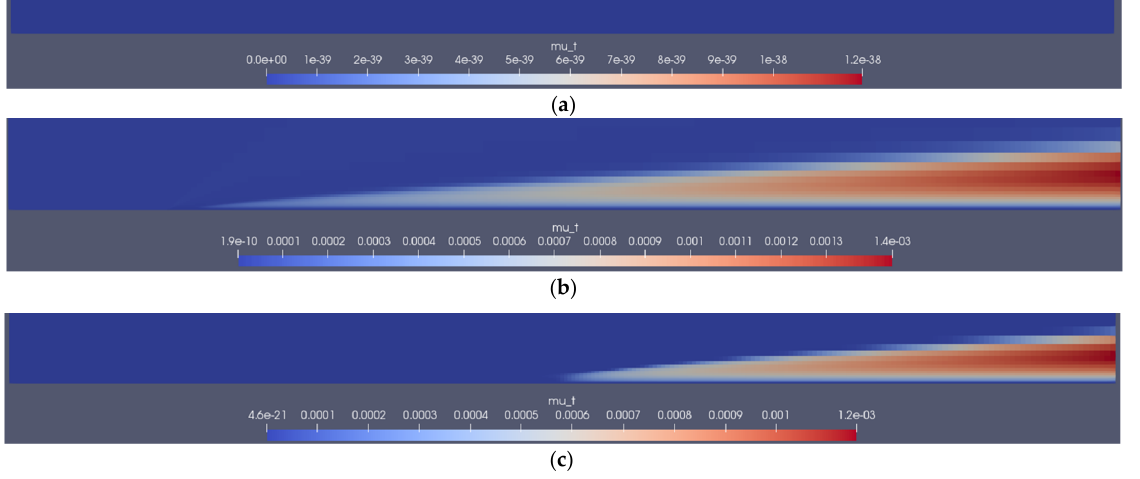
Figure A5. Turbulent onset dynamic viscosity profile of s00: ( a ) laminar model; ( b ) SA model; ( c ) SA-BCM model.